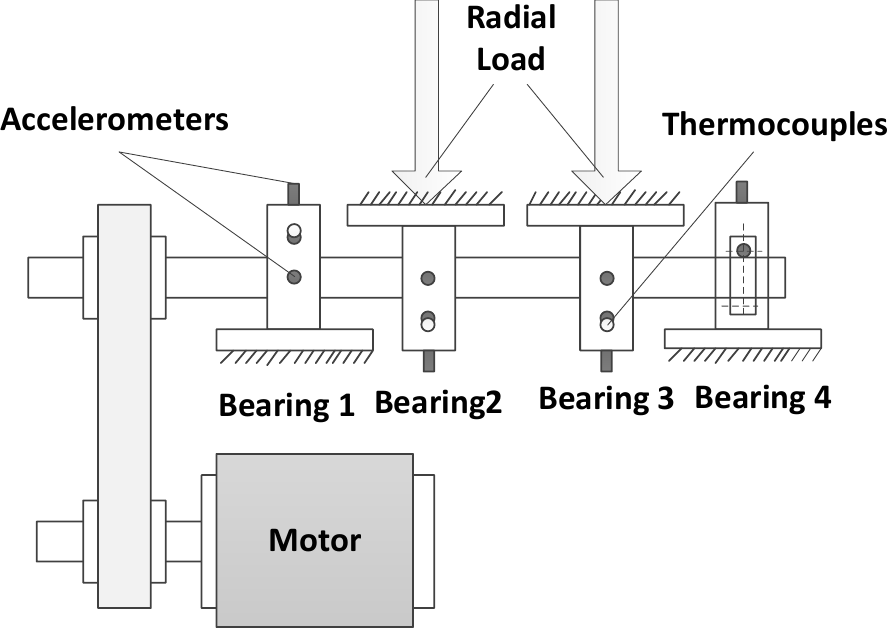
Figure 7. Experimental device diagram of bearing life cycle. Table 2. Description of IMS datasets.